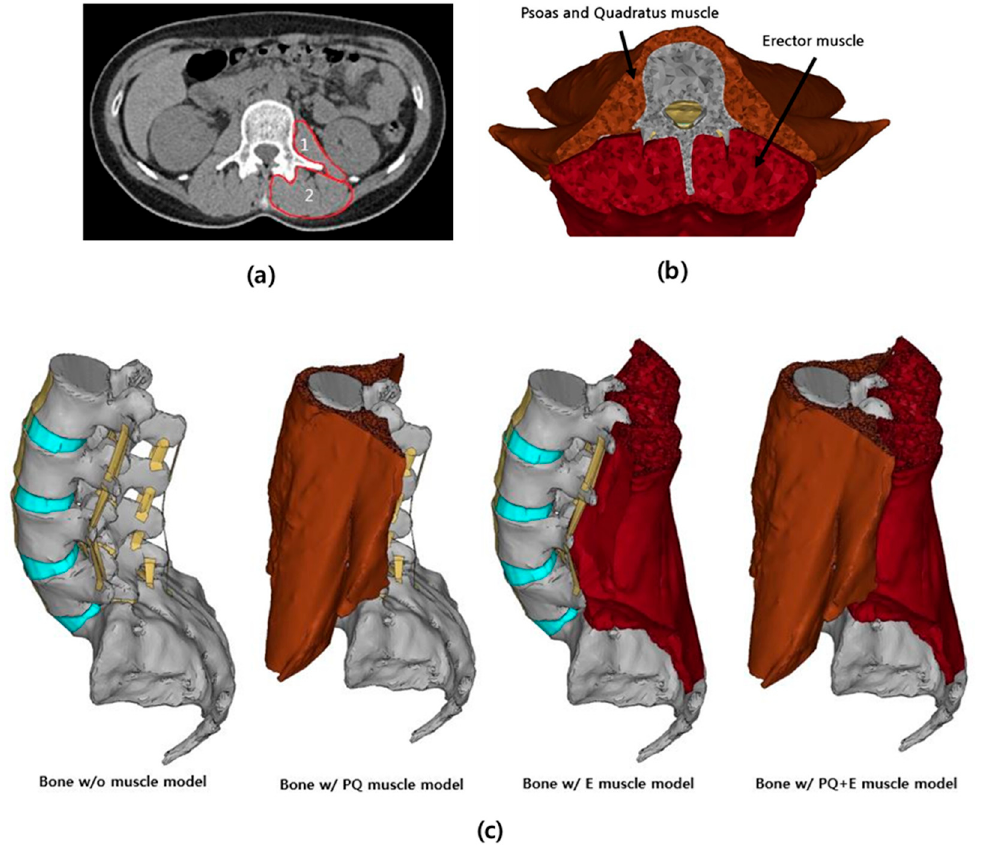
Figure 2. Lumbar musculoskeletal model. ( a ) Computed tomography (CT) photograph and ( b ) 3D element tomographic photograph. ( c ) 3D lumbar musculoskeletal model. PQ muscle: Psoas major and quadratus lumborum muscles; E muscle: Erector spinae muscle.